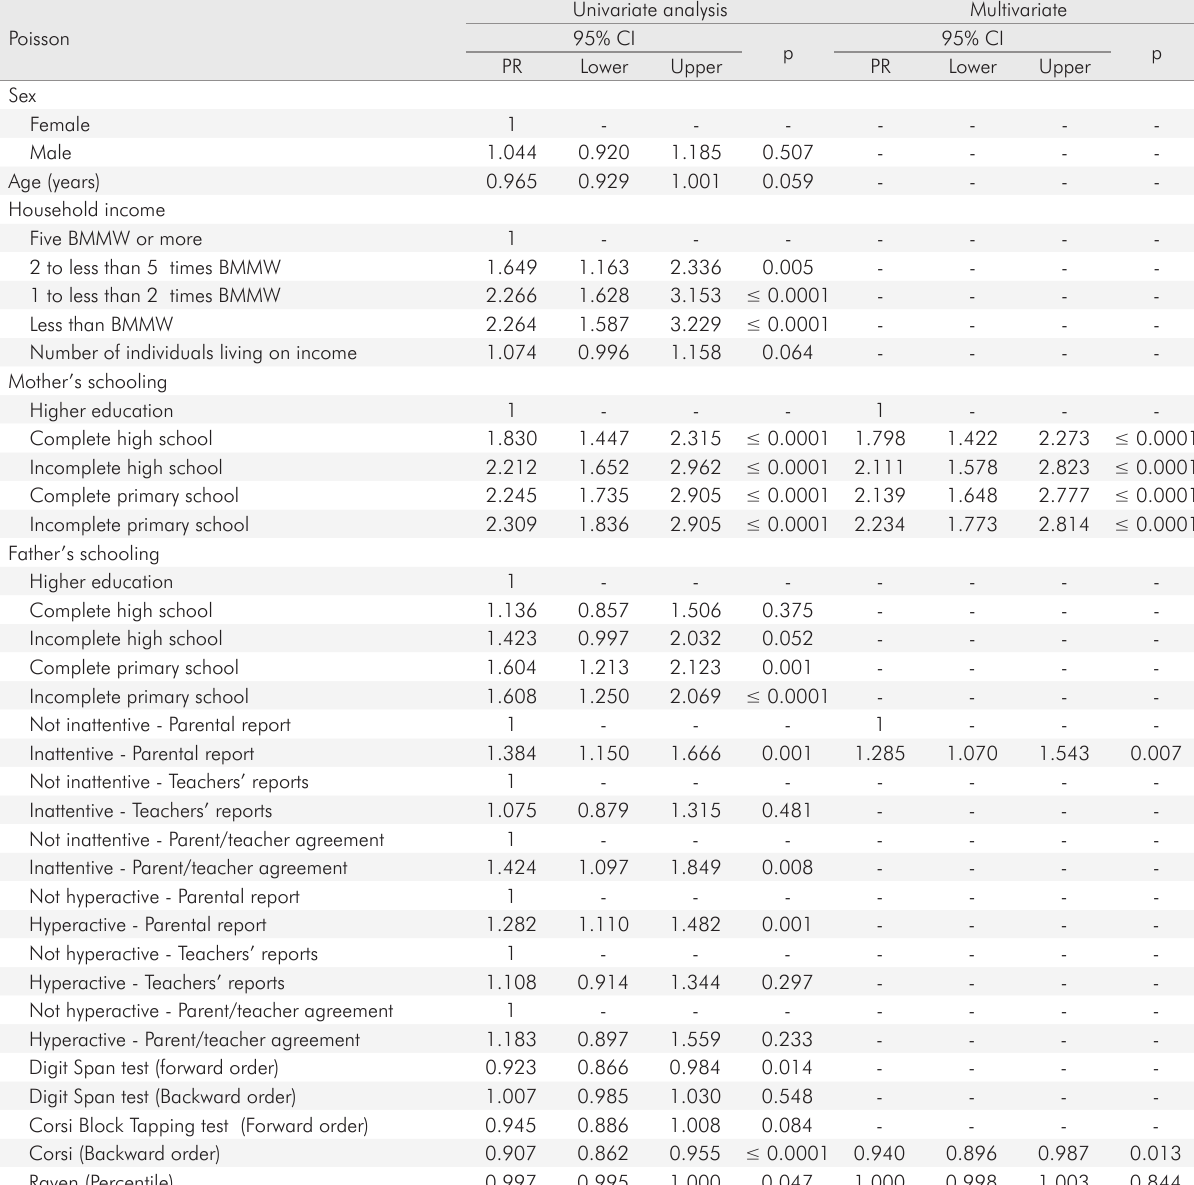
Table 5. Univariate and multivariate Poisson regression considering occurrence of cavitated teeth as dependent variable and socio-demographic characteristics, SNAP questionnaire, and executive functions as independent